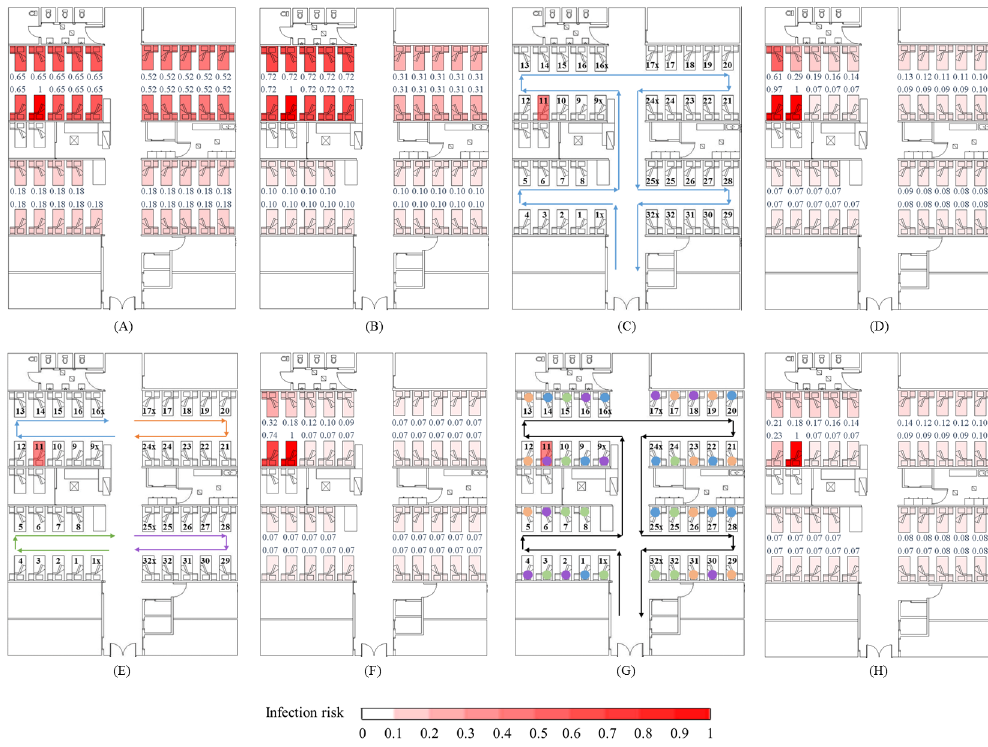
Fig 3. Distributions of reported attack rates and predicted infection risk and HCWs routine round patterns. (A) Reportedattack rates distribution [20]. (B) Predicted averageinfectionrisk distribution (for 1,000 simulations) via the long-range airborneroute at 24:00 on March 12, the end of the exposureperiod. (C) HCWs routine round Pattern 1. (D) Predicted averageinfectionrisk distributionvia the fomite route (Pattern 1). (E) HCWs routine round Pattern 3. (F) Predicted averageinfectionrisk distribution via the fomite route (Pattern 3). (G) HCWs routine round Pattern 5. (H) Predicted averageinfectionrisk distributionvia the fomite route (Pattern 5). The largest virus- containing droplet size d g = 100 μ m, dose–response parameters in respiratory tracts η r = 3.2/mRNA copy and on mucous membranes η m = 3.2 × 10 − 3 /mRNA copy and the viral load coefficient c L = 10. Bed numbersare marked in black in (C), (E) and (G). Reportedattack rates and predictedaverageinfection risks for every inpatientare marked in blue in (A), (B), (D), (F) and (H). The intensity of red shadingrepresentslevels of attack rate or